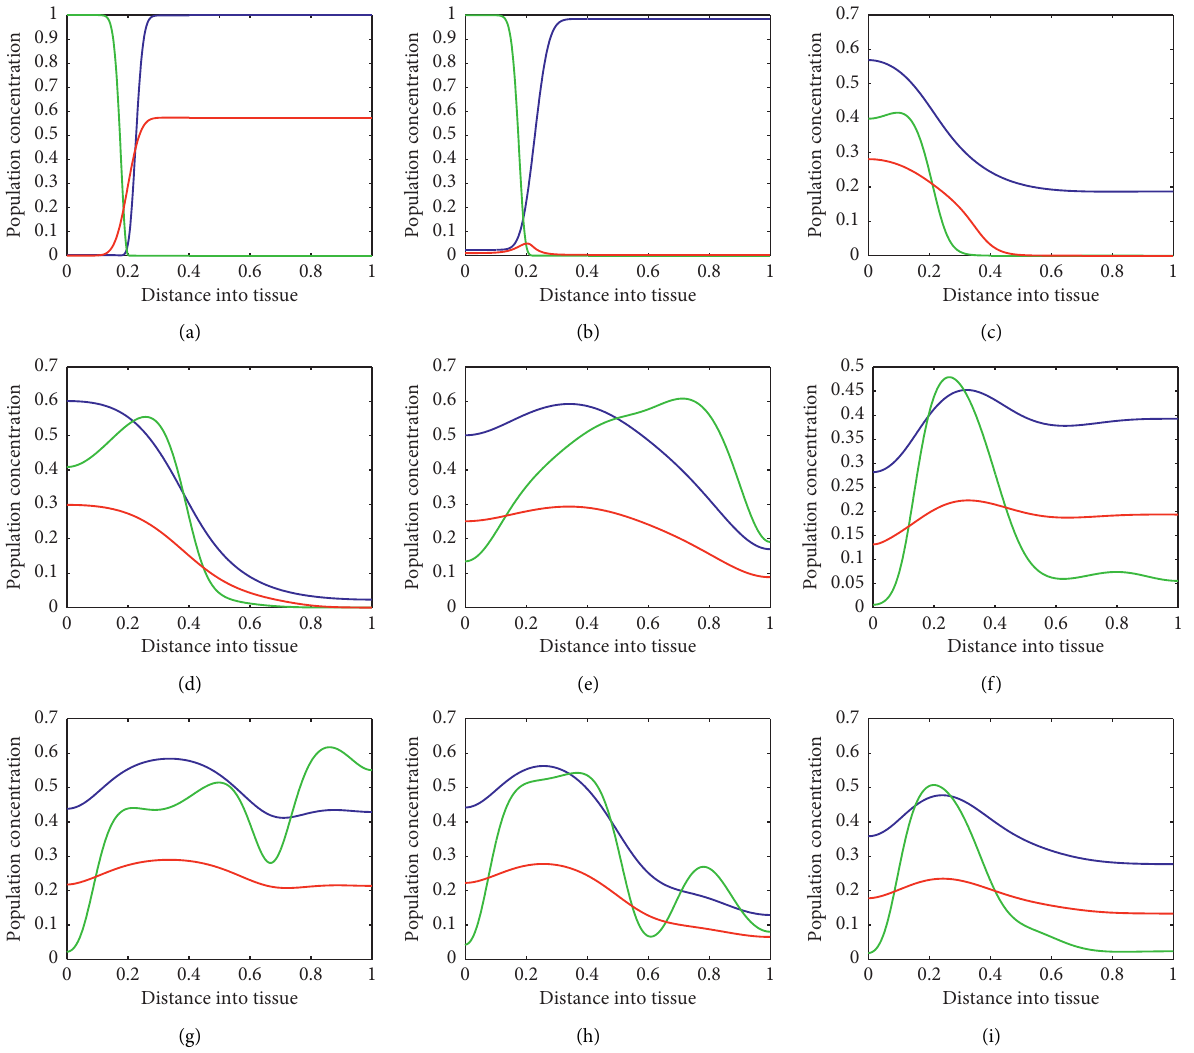
Figure 3: Evolution profiles of the effector cell (blue), the cancer cell (green), and IL-2 (red) concentrations for the cancer cell random � 0 . 00048. (a) t � 0.01. (b) t � 0.1. (c) t � 10. (d) t � 25. (e) t � 35. (f) t � 50. (g) t � 95. (h) t � 400. (i) t � motility coefficient d 2